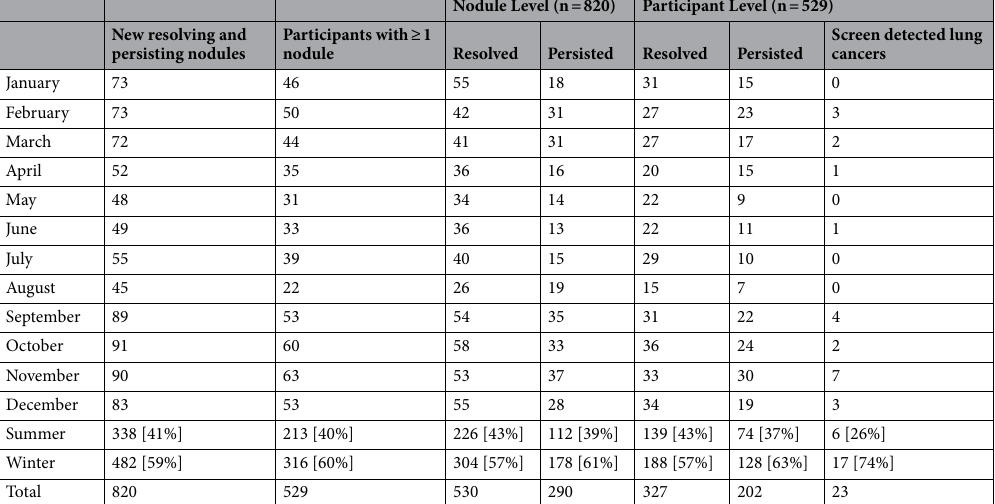
Table 2. Monthly and seasonal distribution of total new nodules, participants with ≥ 1 new nodule and new nodule outcome for both resolving and persisting nodules, and screen detected lung cancers reported during screening rounds two and three of the NELSON trial. Summer (Hay fever season) was defined as 1st April to 30th September, and winter (Influenza season) as 1st October to 31st March.